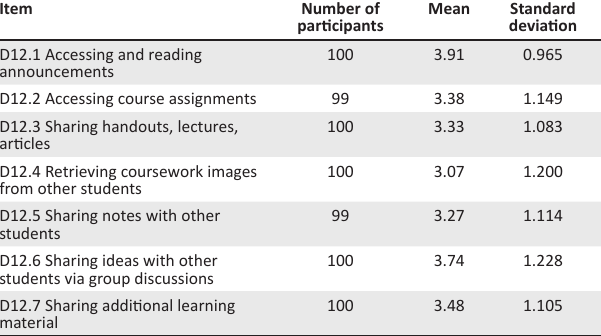
TABLE 1: Descriptive statistics for smart device usage items. Item